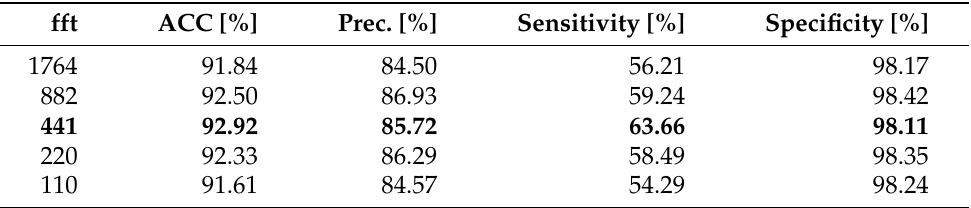
Table 3. The results of the link model on the validation set, depending on the window width fft . The data is from the best of the era. They were obtained by the fivefold cross-validation method.